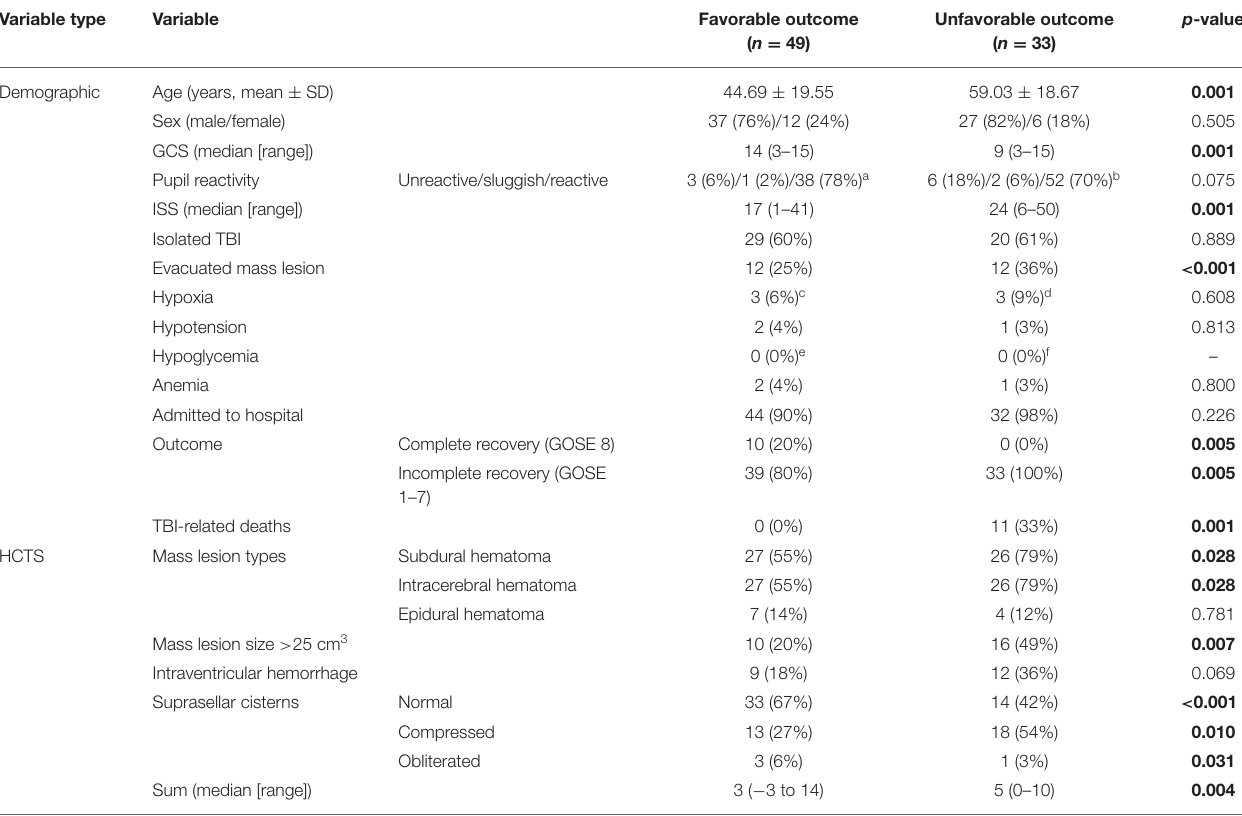
TABLE 2 | Demographics of the main study cohort—Computed tomography-positive patients divided into patients with favorable outcome (Glasgow Outcome Scale—Extended 5–8) and unfavorable outcome (Glasgow Outcome Scale—Extended 1–4). Variable